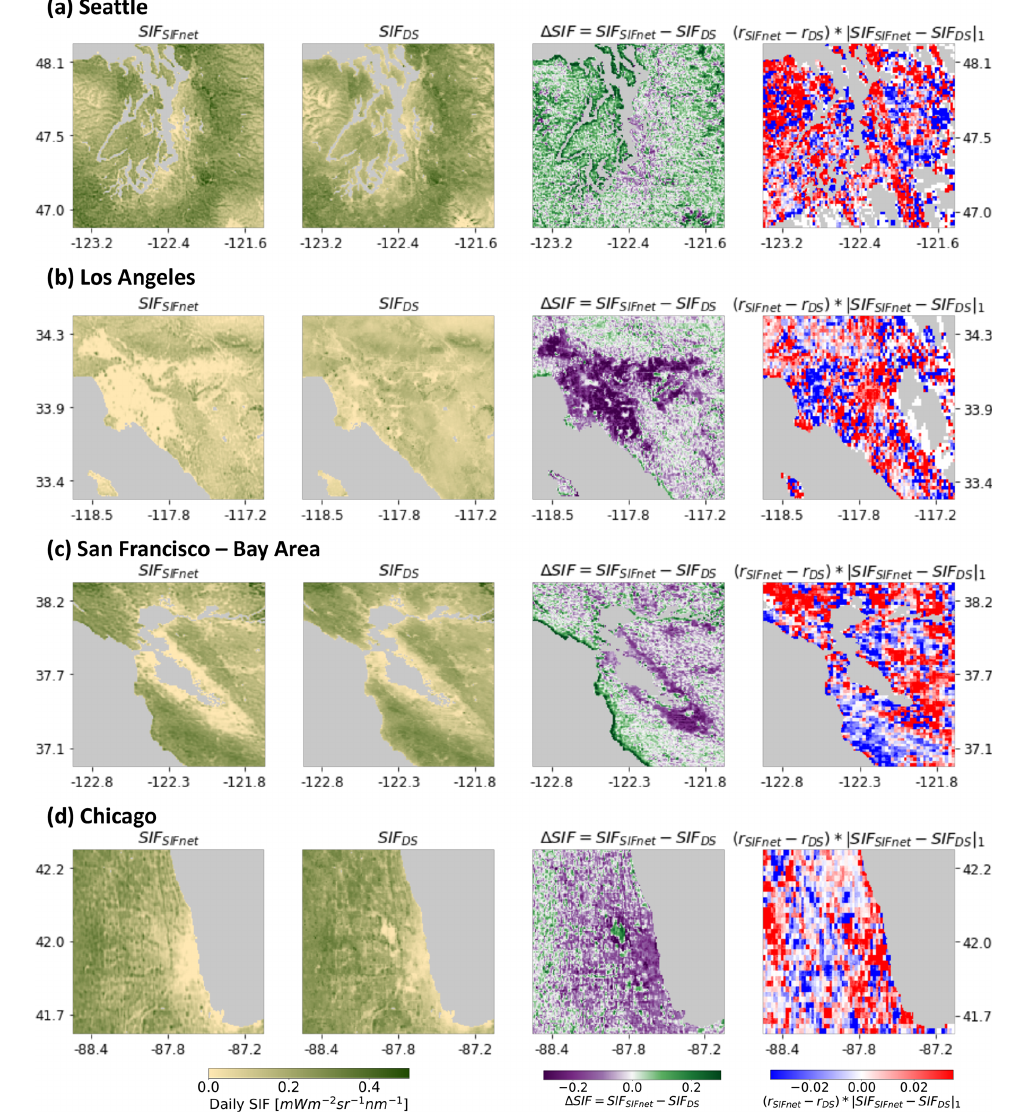
Figure 8. SIFnet and downscaled SIF, the difference between these, and the difference in correlation to OCO-2 and OCO-3 for four urban regions. The first column shows the SIFnet estimate, the second the downscaled SIF from Turner et al. (2020), the third the difference between SIFnet and downscaled SIF, and the last the difference in correlation of the high-resolution SIF estimates to combined OCO-2 and OCO-3 data on a 0.02 ◦ grid multiplied with the L 1 norm between the SIFnet and downscaled